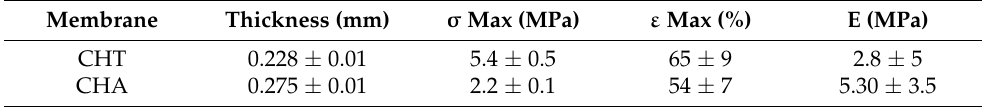
Table 4. Mechanical properties of chañar